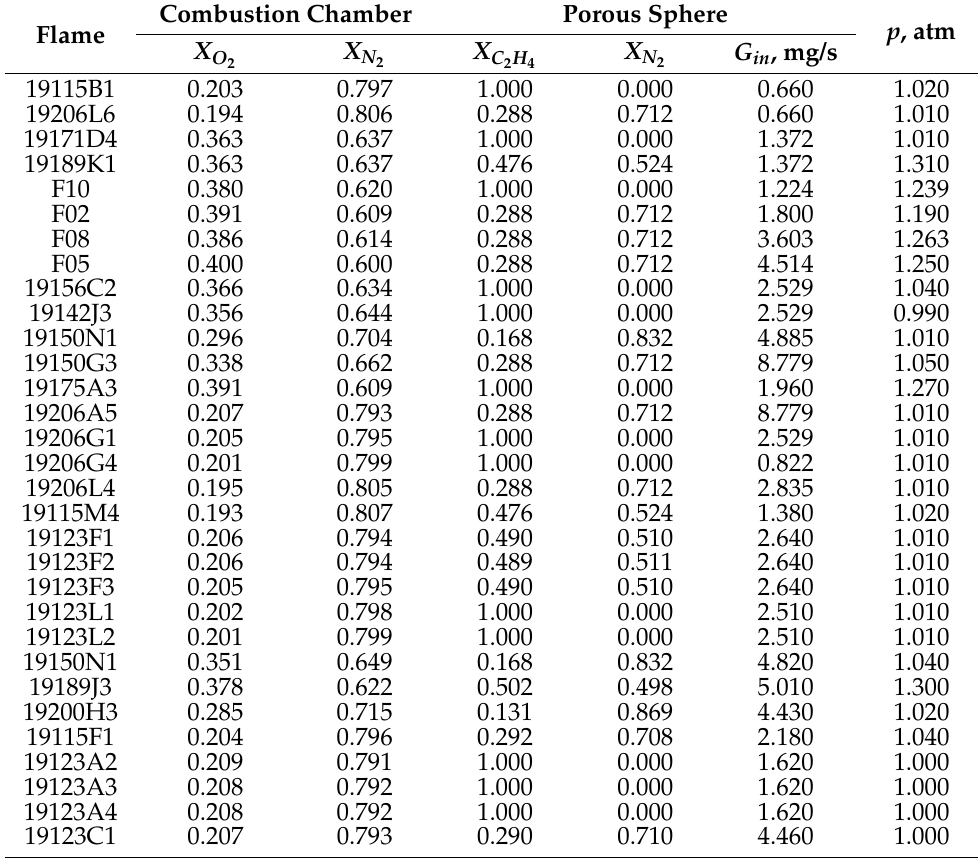
Table 2. Conditions of some normal